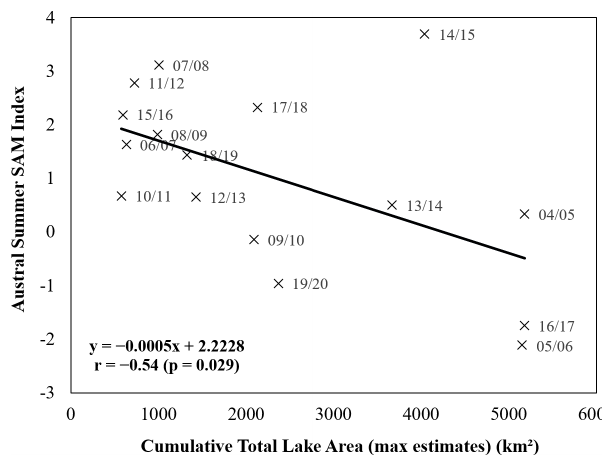
Figure 10. Scatter plot and correlation statistics of the relationship between the austral summer SAM index and cumulative total lake area per melt